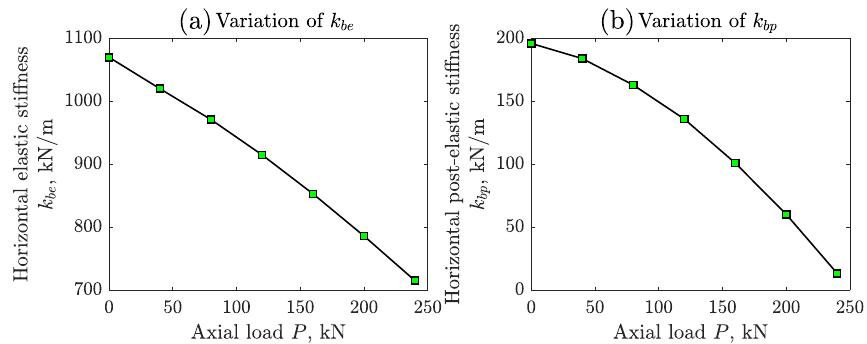
Fig. 7 Variation of horizontal pre- and post-elastic stiffness with axial compression load